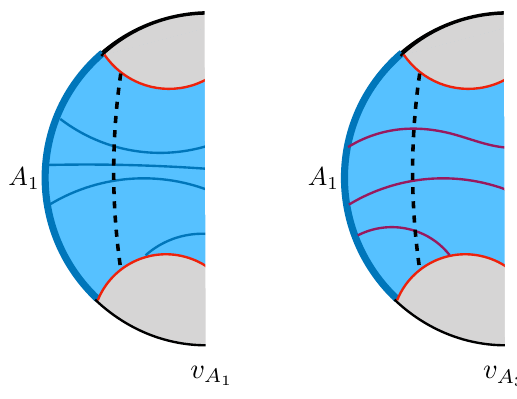
Figure 15 . A portion of the manifold from A 1 . In the example b p ( A 1 ) can support 3 threads.